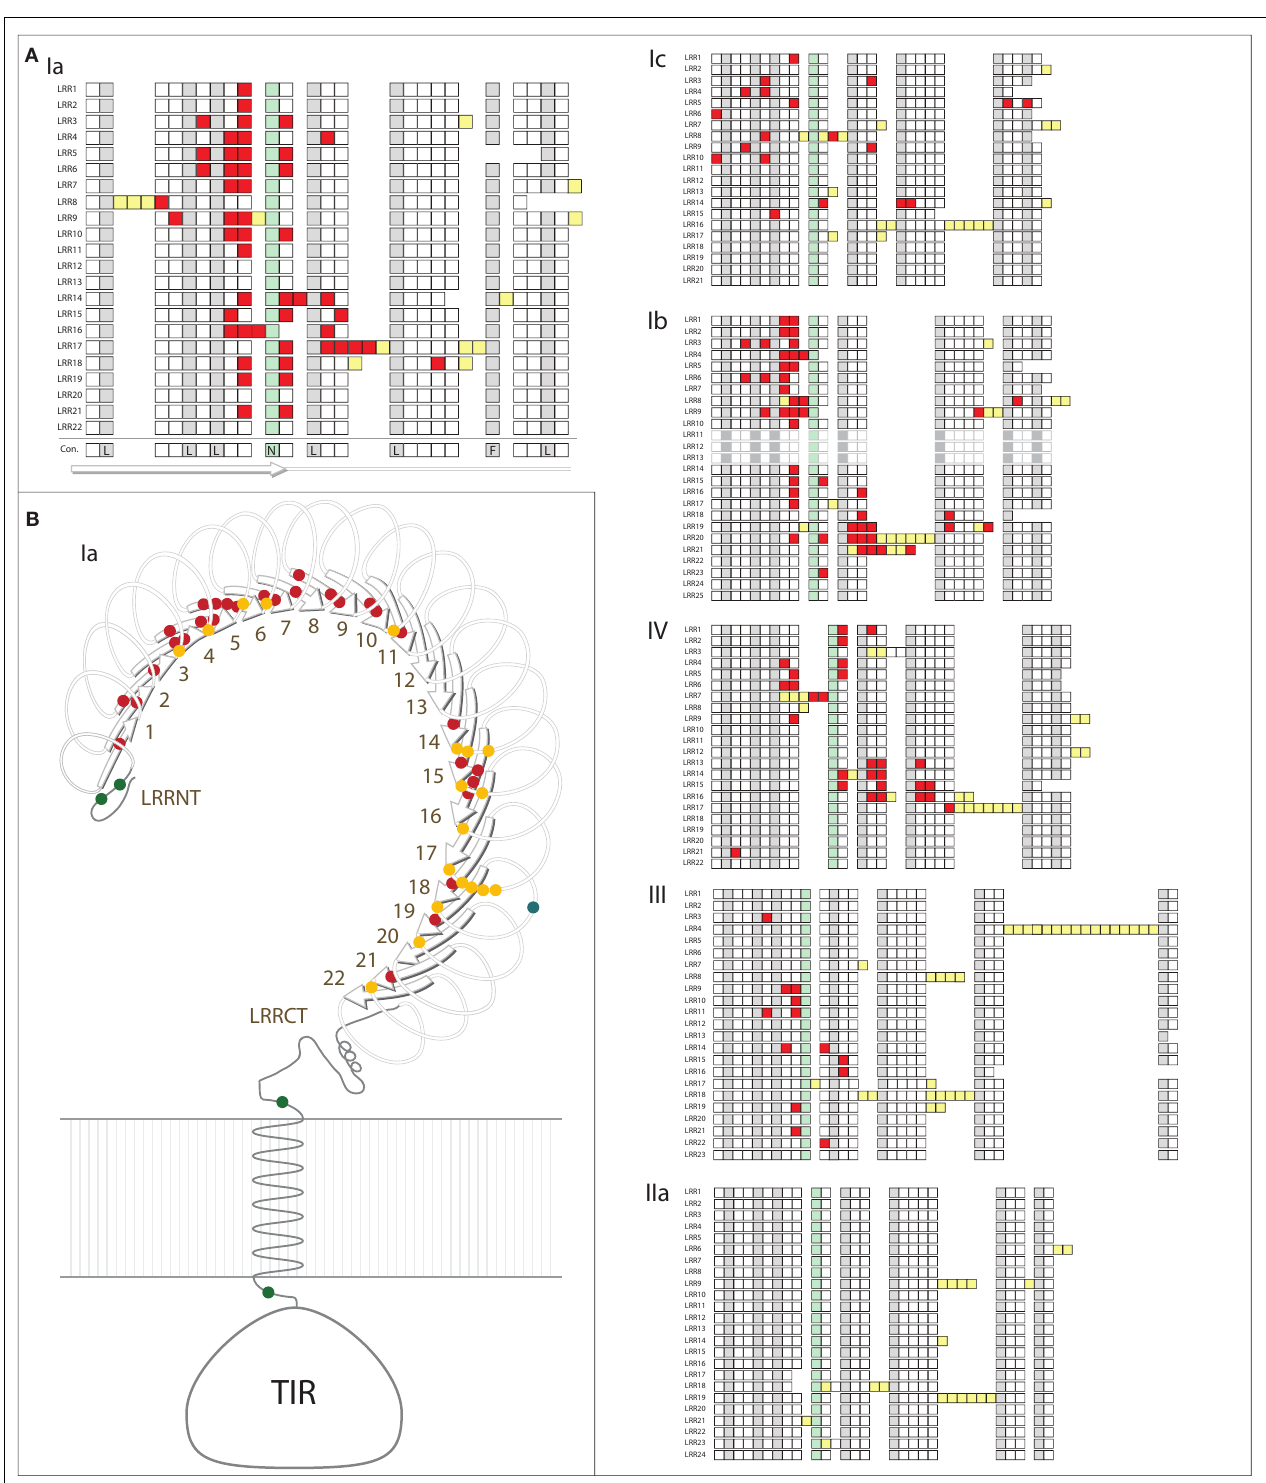
Sequence alignments can be found in Files S1-S6 in Supplementary Material. Each of the LRRs is shown as a single row with individual amino acids indicated as squares. Consensus hydrophobic LRR residues are shown in gray and the conserved asparagines residues are indicated